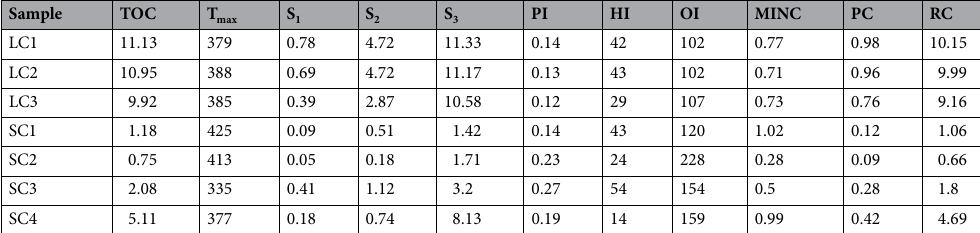
Table 1. Results of Rock–Eval pyrolysis. TOC total organic carbon, in wt.%; T max , temperature, in o C; S 1 , free hydrocarbons, in mg/g rock; S 2 , heavy hydrocarbons, in mg/g rock; S 3 , CO 2 content, in mg/g rock; PI productivity index; HI hydrocarbons index, in mg/g TOC; OI oxygen index, in mg/g TOC; MINC mineral carbon, in wt.%; PC pyrolytic carbon, in wt.%; RC residual carbon, in wt.%